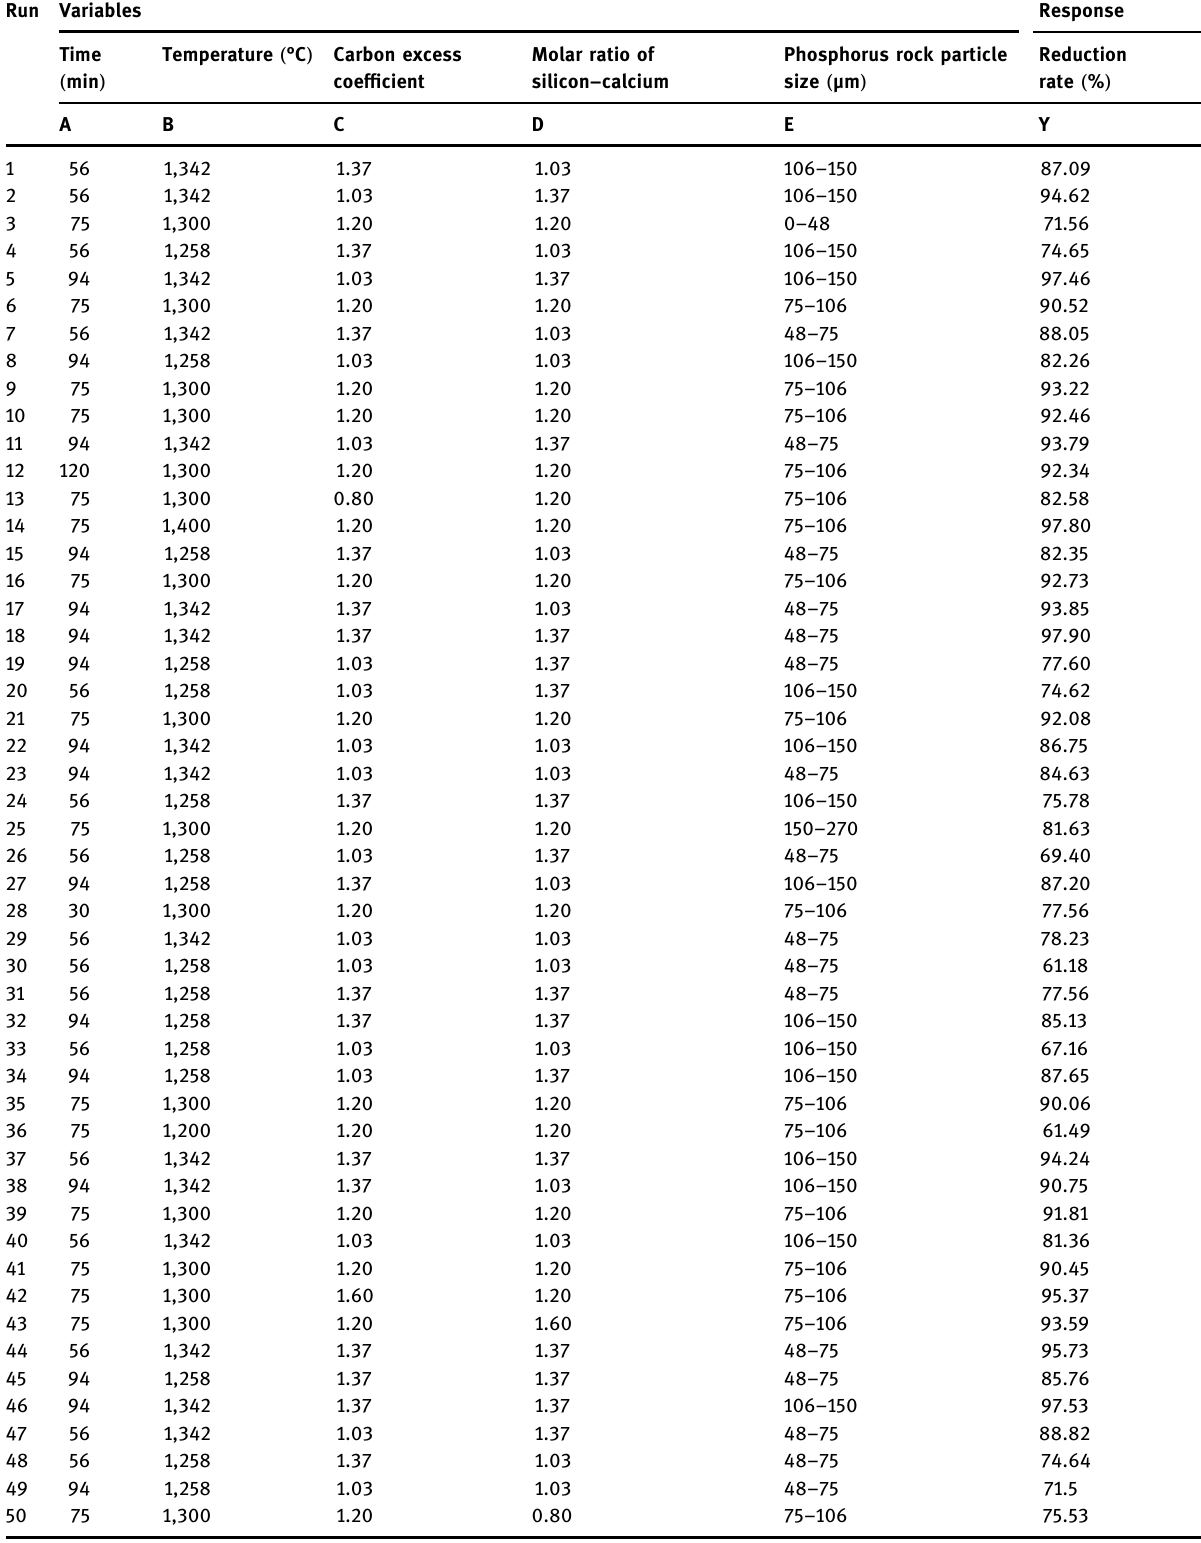
Table 4: Conditions and results of fi fty CCD experiments Run